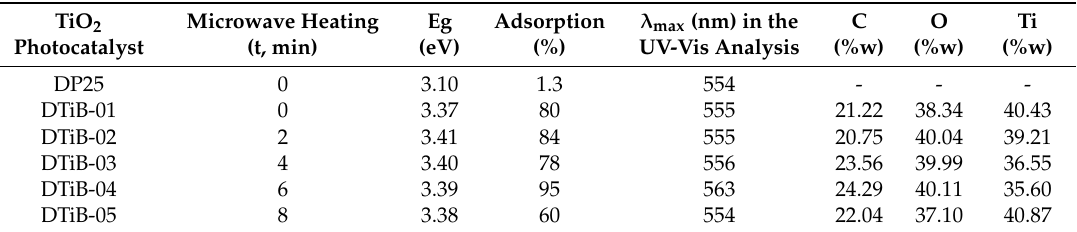
Figure 7. Diffuse reflectance ultraviolet–visible spectroscopy (DRS UV-vis) spectra for all the CD-aTiO 2 samples prepared in this work and for the commercial DP25 TiO 2 .